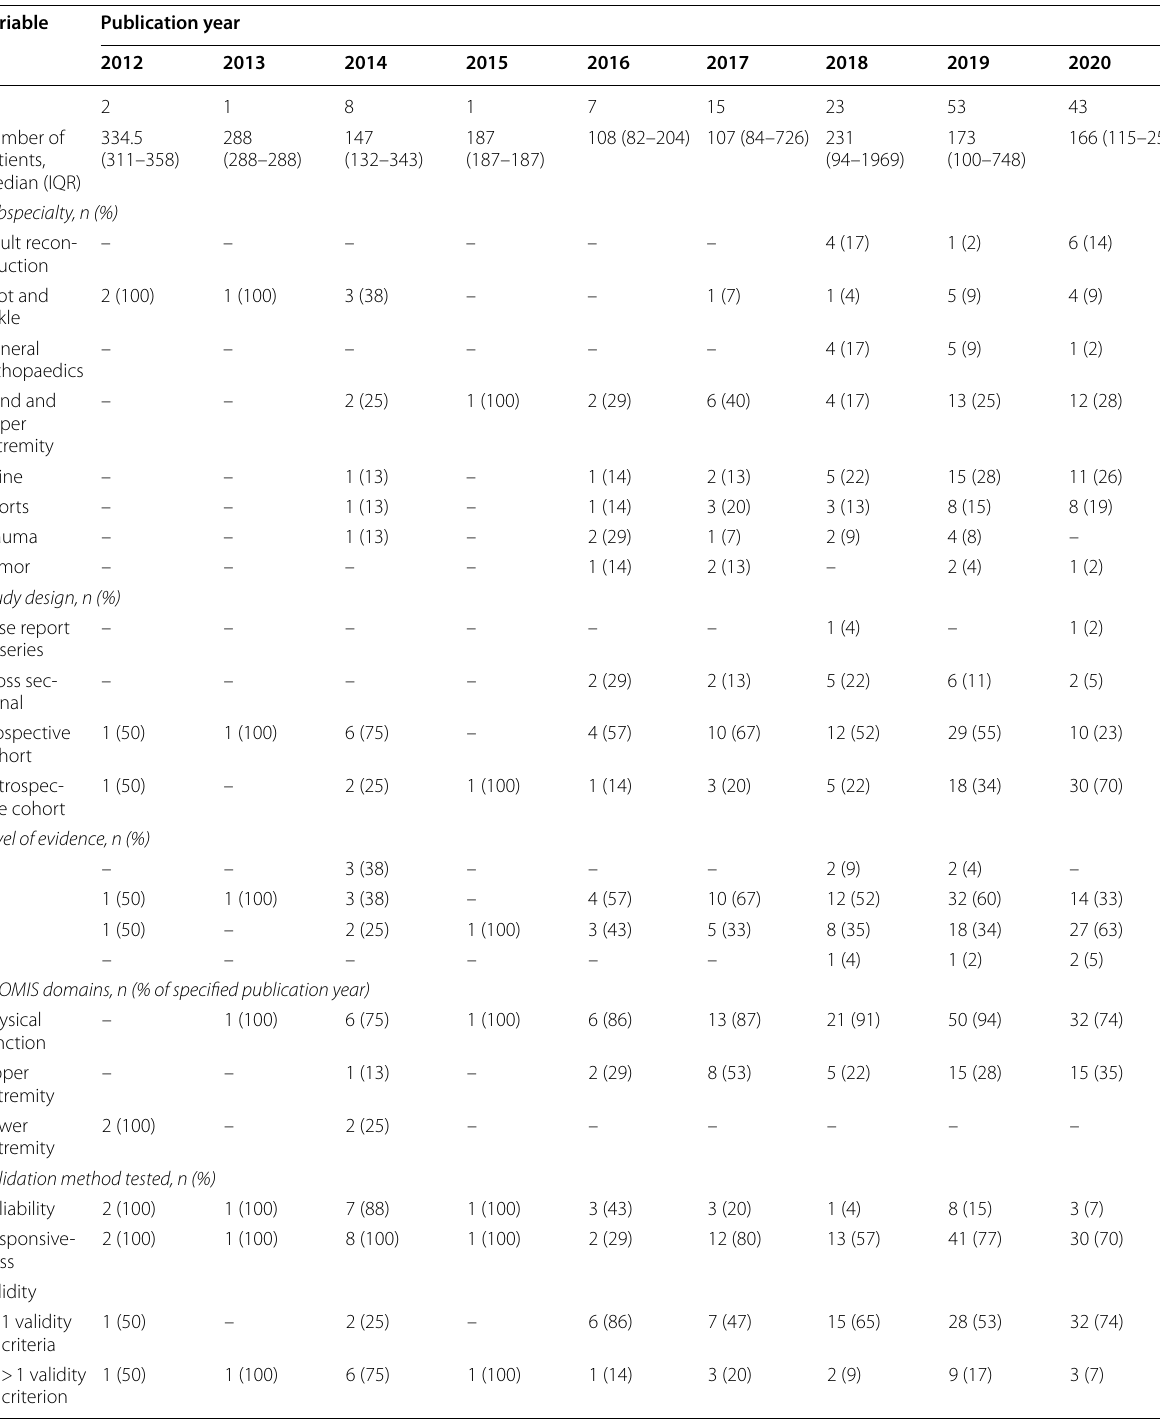
Table 4 Characteristics of publications validating physical health CAT PROMIS domains by publication year (includes physical function, upper extremity, lower extremity)